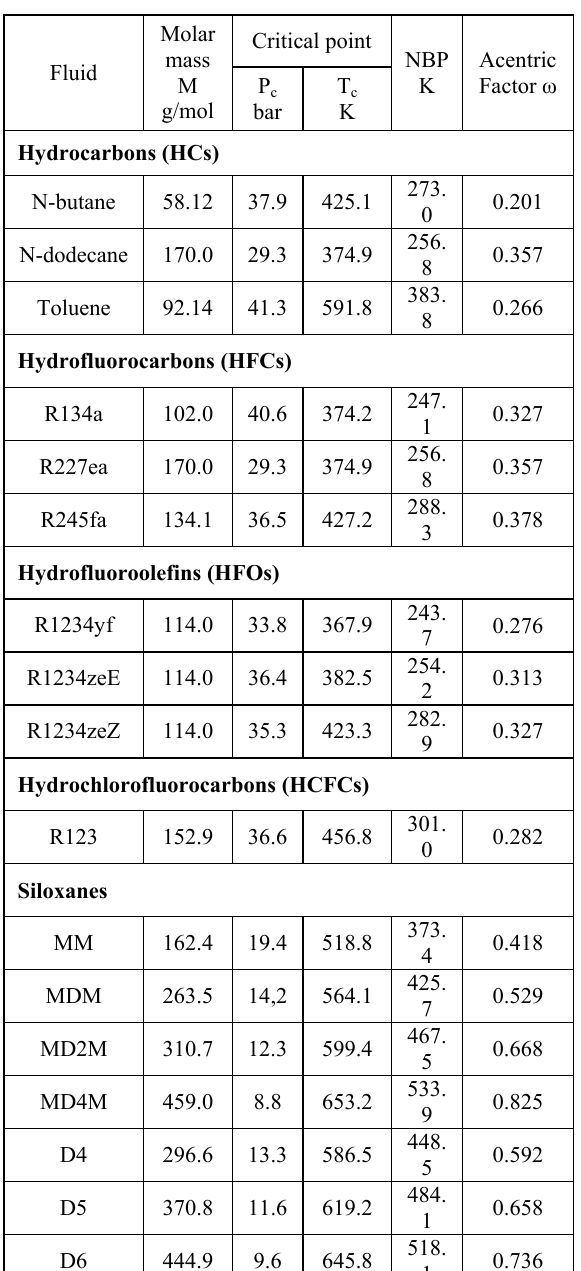
Table 2. Pure working fluid candidates for ORC